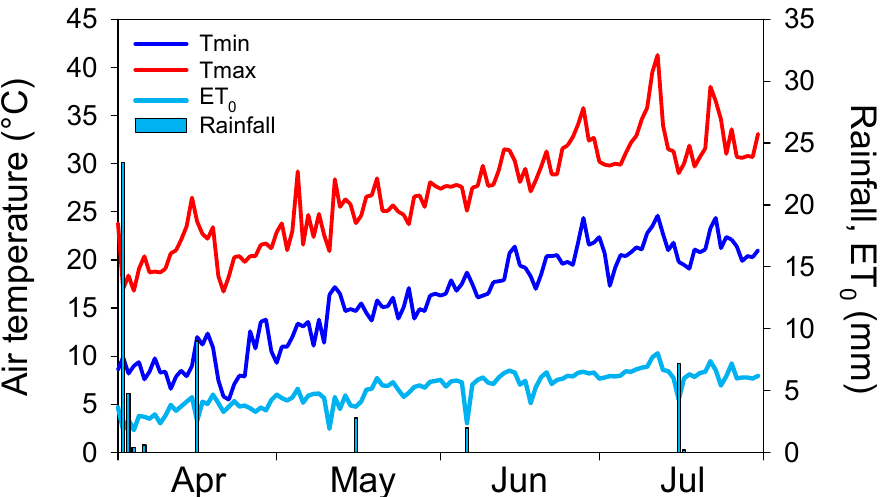
Figure 1. Meteorological course (maximum-Tmax and minimum-Tmin air temperatures, rainfall, reference evapotranspiration-ET 0 ) recorded during the field experiment.